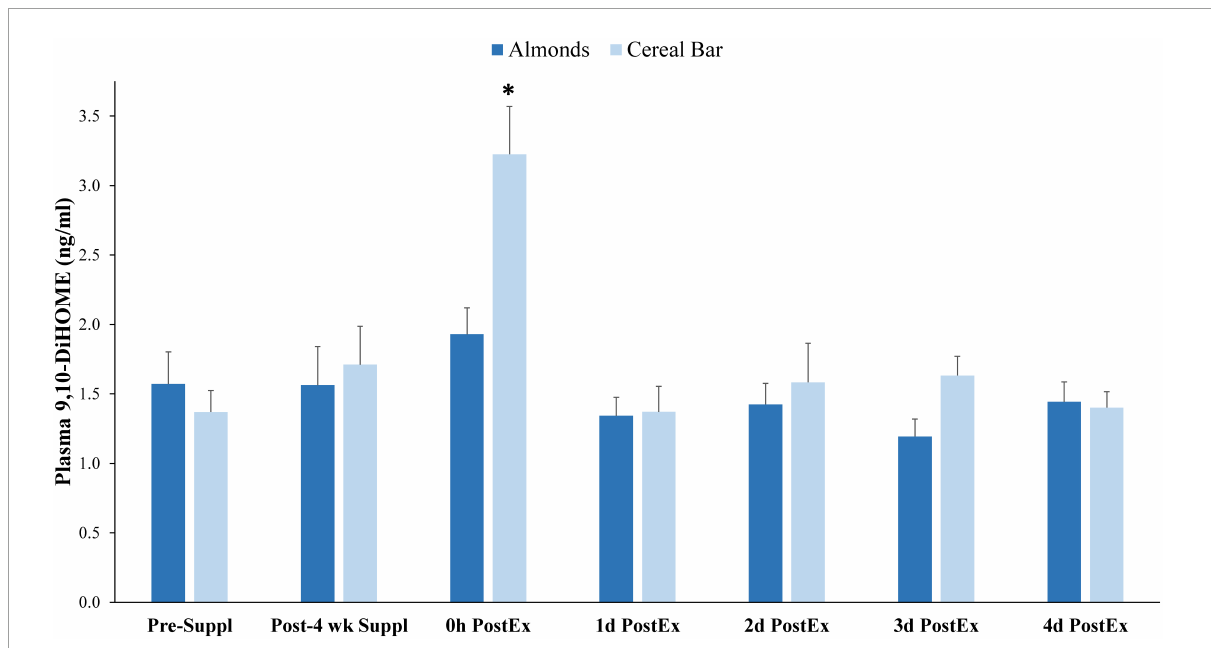
FIGURE4 Plasma 9,10-DiHOME data before and after 4-weeks supplementation, and immediately post 90 min eccentric exercise and in an overnight fasted state during 4 days of recovery (AL = almond, n = 33; CB = cereal bar, n = 31) (means ± SE). Time effect, p < 0.001, interaction effect, p < 0.001, q < 0.10. ∗ p -value = 0.0013, group contrast of the increase relative to pre-supplementation. Suppl, supplementation; PostEx, post-90 min eccentric exercise bout.